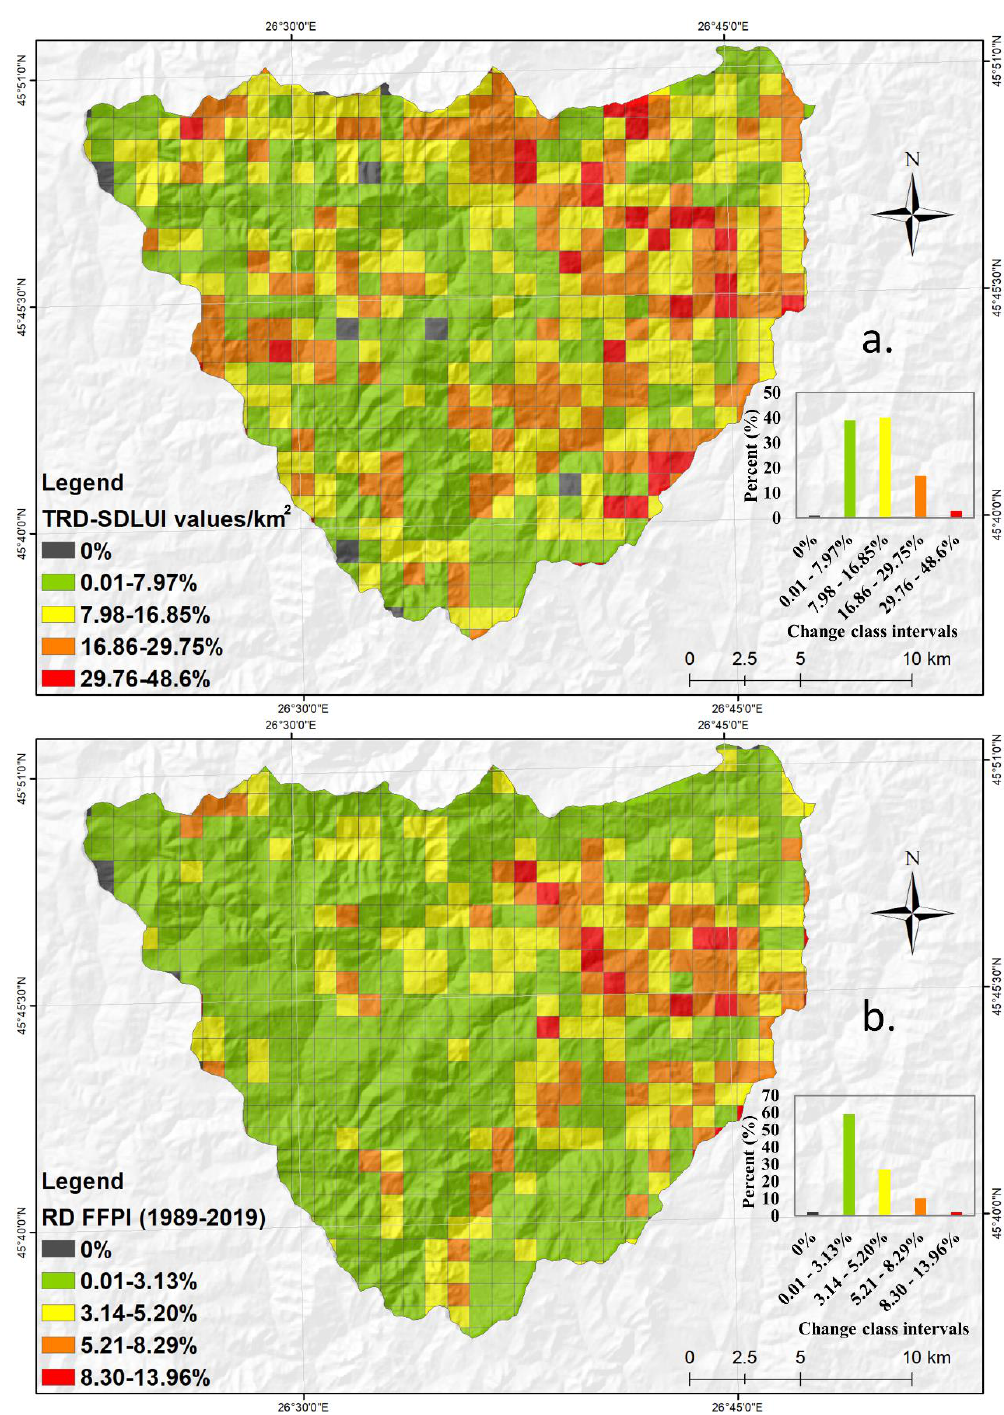
Figure 10. Spatial distribution of ( a ) TRDSDLUI and ( b ) RD-FFPI at grid level.